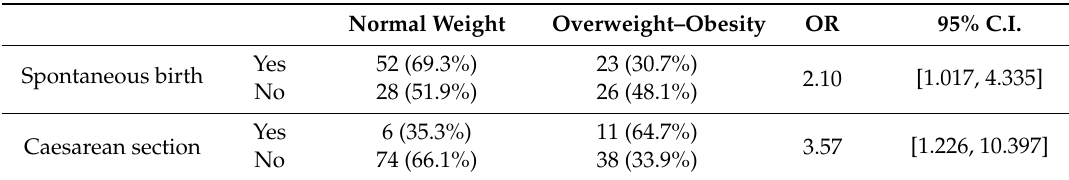
Table 3. Odds ratios according to first-trimester BMI. Normal Weight